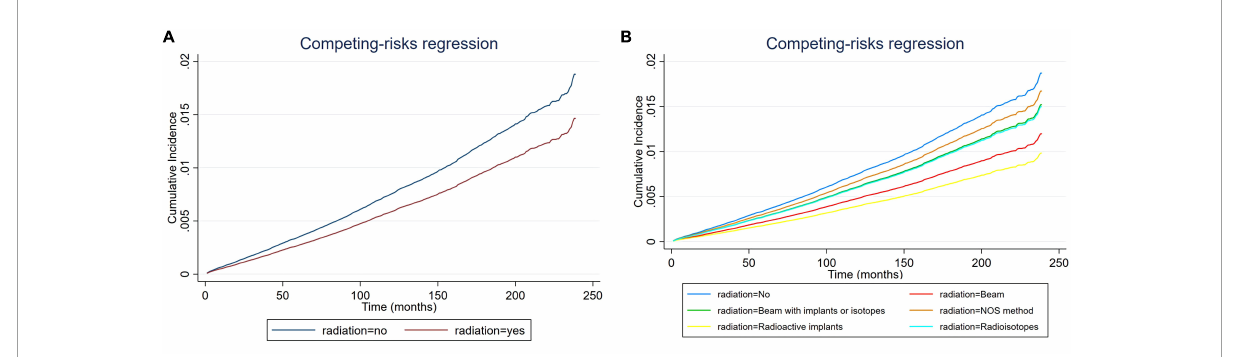
FIGURE2 Cumulative incidence rate of cardiac-specific death related to radiation therapy (RT) before propensity score matching (PSM) (the curves of “radioactive isotopes” and “beam with implants or isotopes” are overlapping and may not be drawn separately). The Y -axis of each panel shows the cumulative risk of cardiac-specific death and the X -axis shows the time since diagnosis in months. Each line represents the cumulative risk of cardiac-specific death in patients after receiving a treatment. (A) Cumulative risk of cardiac-specific death in patients with receiving and not receiving radiotherapy. (B) Cumulative risk of cardiacspecific death in patients with not receiving radiotherapy and receiving different modalities of